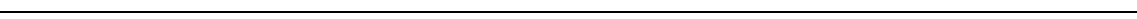
Fig. 2 MMP12 cleaves IFN- γ removing the IFN- γ receptor-binding site. a Silver stained 15% SDS-PAGE analysis of in vitro cleavage of human (h) IFN- γ by 10 or 100 ng hMMP12 catalytic domain at 1:10 and 1:100 enzyme to substrate ratios, incubated over 18 h at 37 °C. Revealing C-terminal cleavage, N- terminal sequencing identi fi ed an intact N-terminus commencing at 1MQDPY both in IFN- γ and in the two cleavage products (red arrows). The MMP12- speci fi c inhibitor, Rxp470.1, blocked IFN- γ cleavage and autocatalytic cleavage of MMP12 resulting in stabilized MMP12 protein levels over 18 h. Molecular weight marker positions are shown. b Q-TOF-MS analysis of IFN- γ cleavage reaction products revealed C-terminal cleavage fi rst between 157Met ↓ Leu158 and then at 135Glu ↓ Leu136 (see Supplementary Fig. 4). The k cat / K M values calculated for each cleavage event in human and mouse (m) IFN- γ are shown. c Based on the crystal structures of the IFN- γ homodimer (pdb entry: 1HIG) 33, 51 , a secondary complex consisting of the IFN- γ dimer, two high-af fi nity IFN- γ receptor 1 molecules (IFNGR1(pdb entry: 1FG9); 29Val-Ser241; dark gray), and two low af fi nity IFN- γ receptor 2 chains (IFNGR2 (pdb entry: 1FYH); 30Leu- Thr237; light pink) were modeled. The IFN- γ C-terminal peptide (135Glu – 158Leu) responsible for IFN- γ receptor interaction and signaling was modeled (green). The transmembrane peptide and JAK1/2 are shown in cartoon form. d Frontal view of the structured region of the IFN- γ homodimer with the C- terminal non-structured fl exible region (from 146Ala to Gln166) cartooned in green. The two MMP12 cleavage sites are shown: 157Met ↓ Leu158